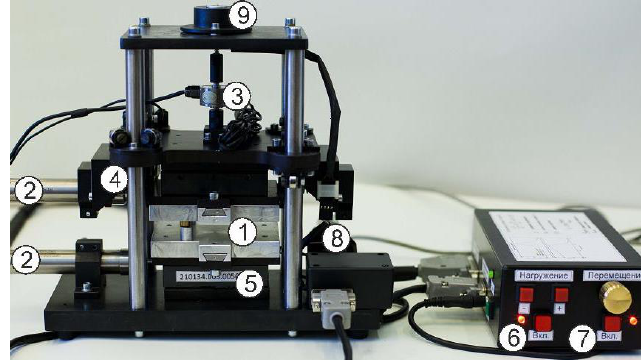
Fig. 1. The schematics of the device